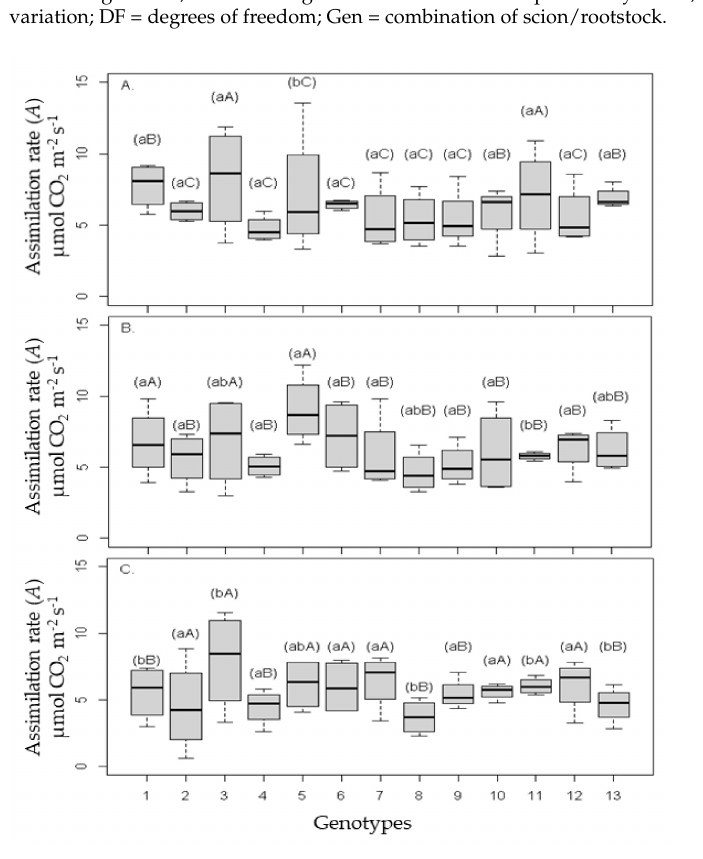
Figure 11. Boxplot relative to the assimilation rate ( A ) of 13 citrus rootstocks in combination with ‘Tahiti’ acid lime ( Citrus × latifolia (Yu. Tanaka) Tanaka) under irrigation with waters of 0.14 ( A ), 2.40 ( B ), and 4.80 dS m − 1 ( C ), in the first year. For identification of genotypes, see Table 1. Boxplots with the same lowercase letter do not differ statistically, according to the Tukey test between salinity levels ( p ≤ 0.05), and those with the same uppercase letter belong to the same genotype group, according to the Scott–Knott test ( p ≤